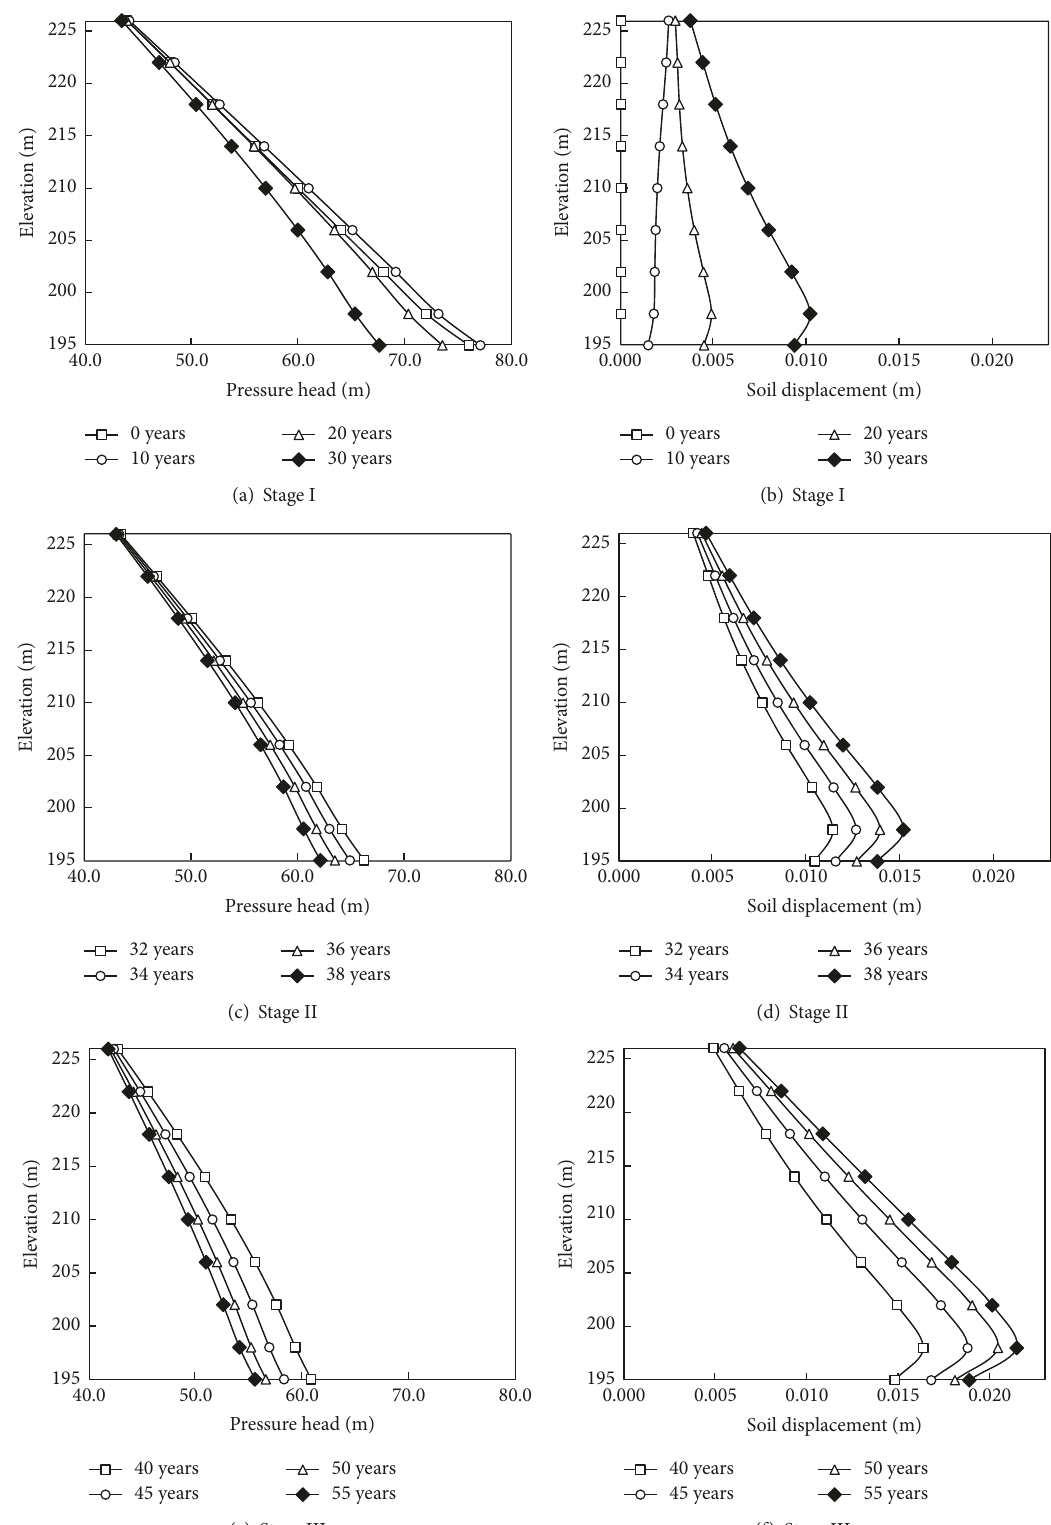
Figure 3: Distribution of pressure head and soil displacement in aquitard I during different